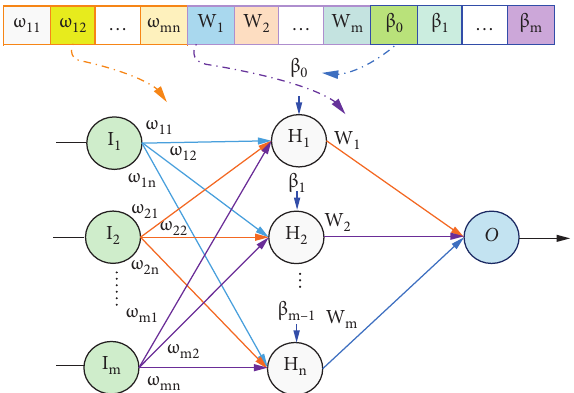
Figure 7: Solution structure in MLP-optimization model [35].